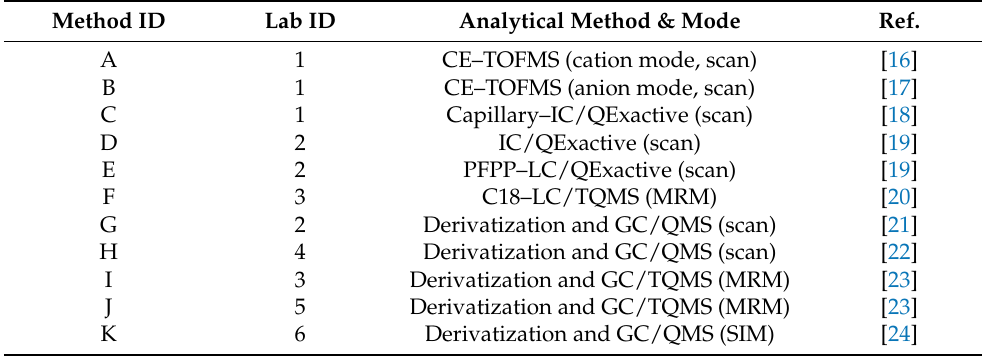
Figure 1. Analytical procedure in the current study. Nine laboratories (Lab. 1 to Lab. 9) participated in this study. In the hub laboratory, identically extracted samples were prepared from two kinds of plasma (human and mouse plasma), and their mixed plasma was distributed to the nine participating laboratories throughout Japan. In each laboratory, metabolomics was carried out without conducting any work other than the pretreatment required for each analysis, and 18 analytical methods were employed to extract each sample. After data submission to the hub laboratory, the data integration and data analysis were performed. Table 1. Analytical methods for the hydrophilic